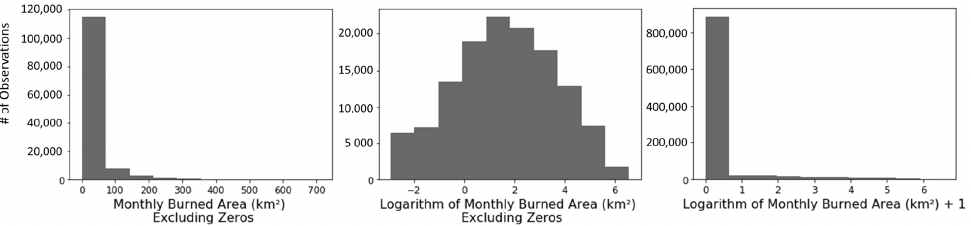
Figure 1. Histograms of burned areas. A histogram of monthly burned areas throughout the data’s time span. The left subplot excludes non-burned observations. The middle subplot presents the logarithm of the same data. The right subplot presents the logarithm (1 + x) of the entire data (including non-burned observations).